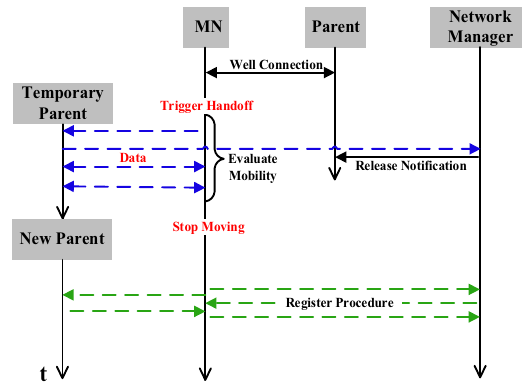
Figure 6. The sequence of handoff procedure.